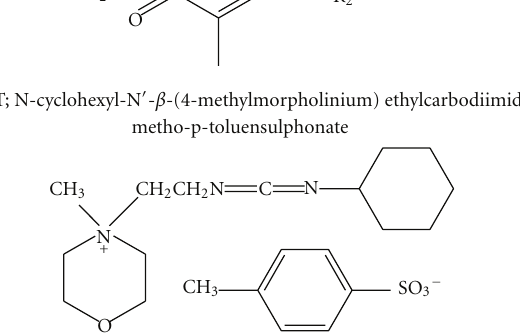
Figure 7: The CMCT reaction of pseudouridine ( Ψ ) and uridine, and the structure of CMCT [11]. Adducts formed with CMCT on Ψ and U are shown. This adduct formation prevents the cleavage by RNase A at U but not at C. The mild alkaline treatment of reaction products destroys the U but not the Ψ . These di ff erences were utilized to locate the position of Ψ by reverse transcriptase.